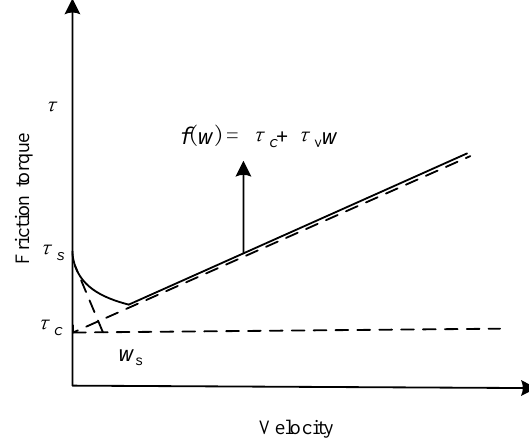
Figure 4. Stribeck model.